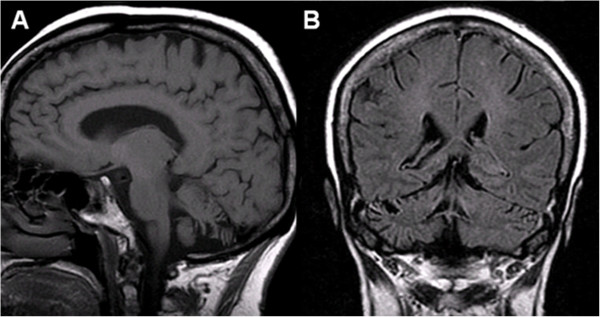
Magnetic resonance imaging of the brain, patient 1. Sagittal (A, T1 weighted) and coronal (B, FLAIR T2 weighted) MRI showing cortical atrophy in the cerebellar hemispheres and the inferior vermis with enlargement of the cerebellar sulci, the fourth ventricle and the inferior cerebellar cistern, but no atrophy of the cerebral cortex, midbrain, or pons.